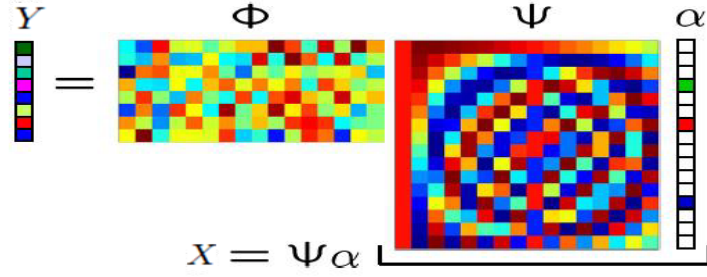
Figure 1. The scheme of compressive